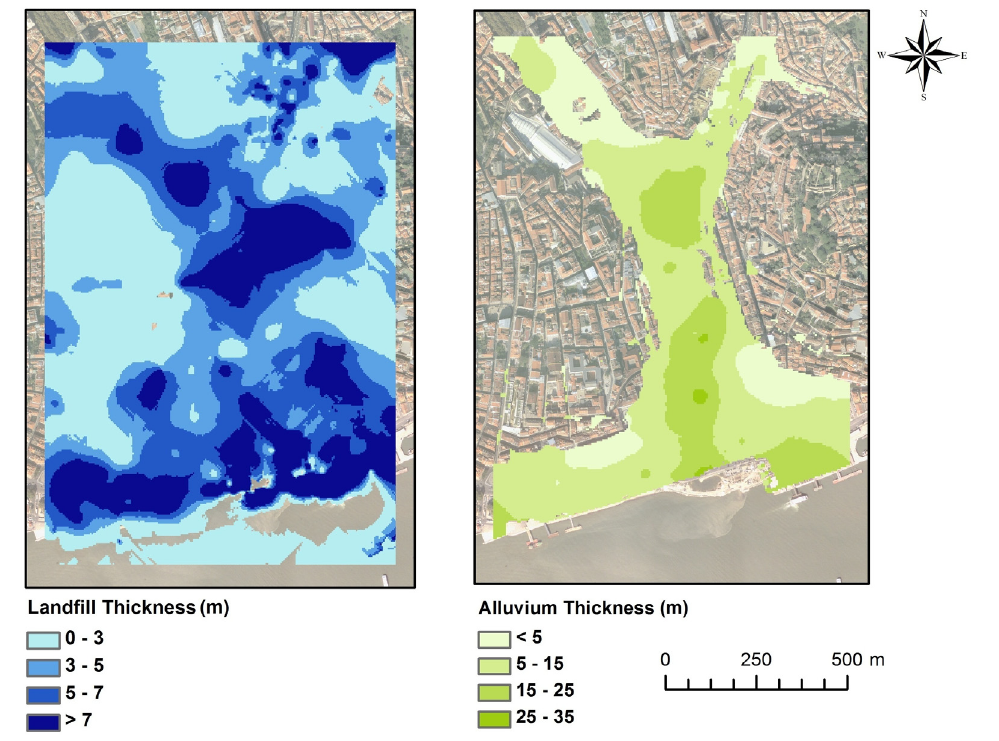
Figure 3. Thickness of anthropogenic deposits (left) and alluvial deposits (right) in